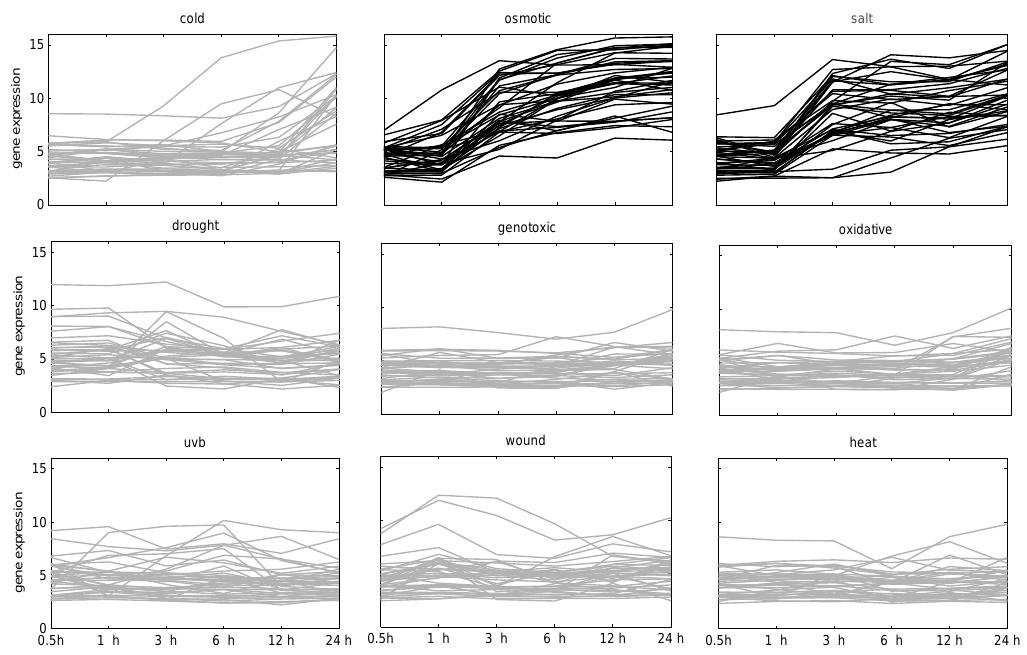
Figure 4: Coherent module found for salt/shoot as initial condition ( p -value: 7 . 12 · 10 − 7 ). All other conditions do not receive a p-value below 5 % and are therefore not included into the